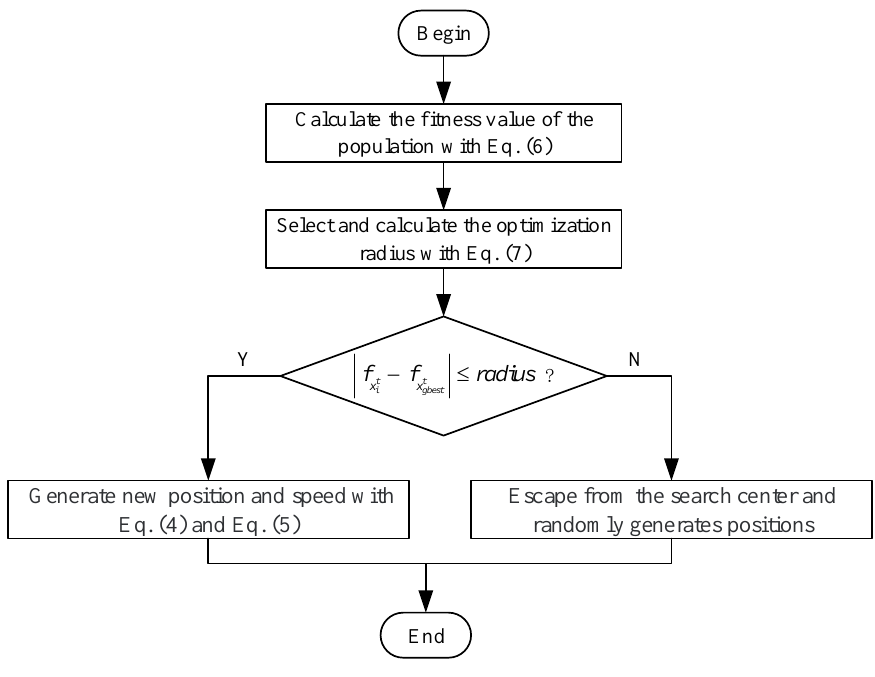
Figure 1. The flow chart of the adaptive bat algorithm search.